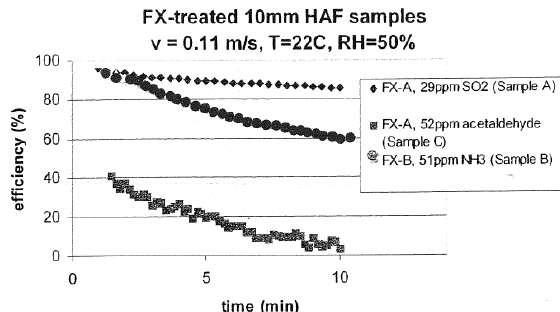
Figure 2. Efficiency of 10 mm HAF filter coated with FX solutions.